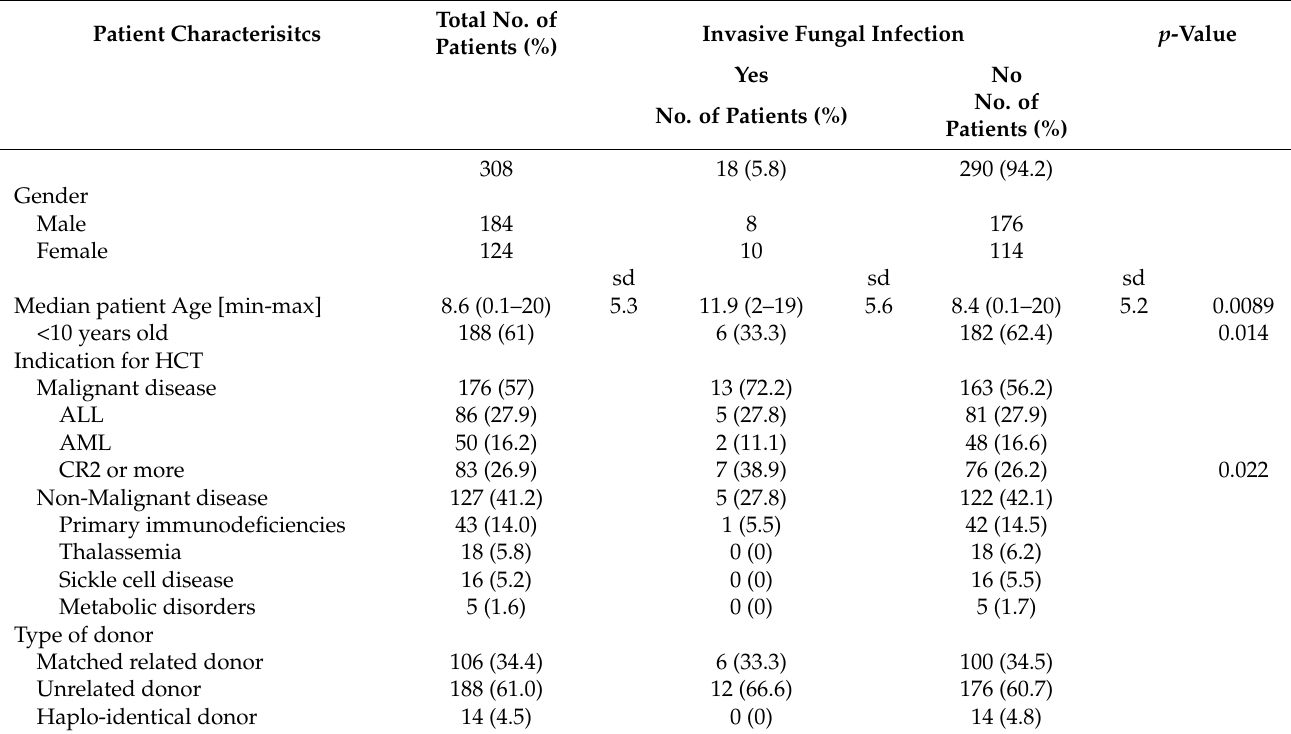
Table 1. Clinical characteristics of 308 pediatric allogenic HCT